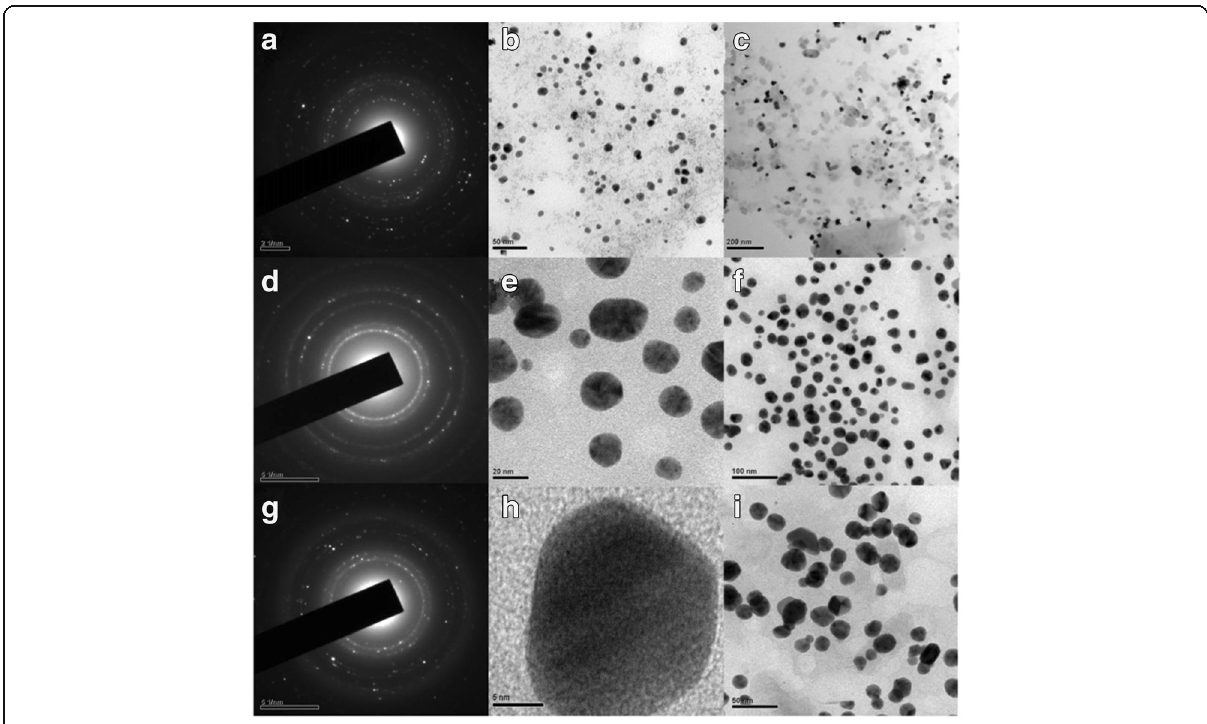
Fig. 10 TEM images and SAED patterns of colloids the volume of leaf extract 4 ml (Ct4) ( a – c ), Ct3 ( d – f ), and Ct1 ( g – i ) nanoparticles